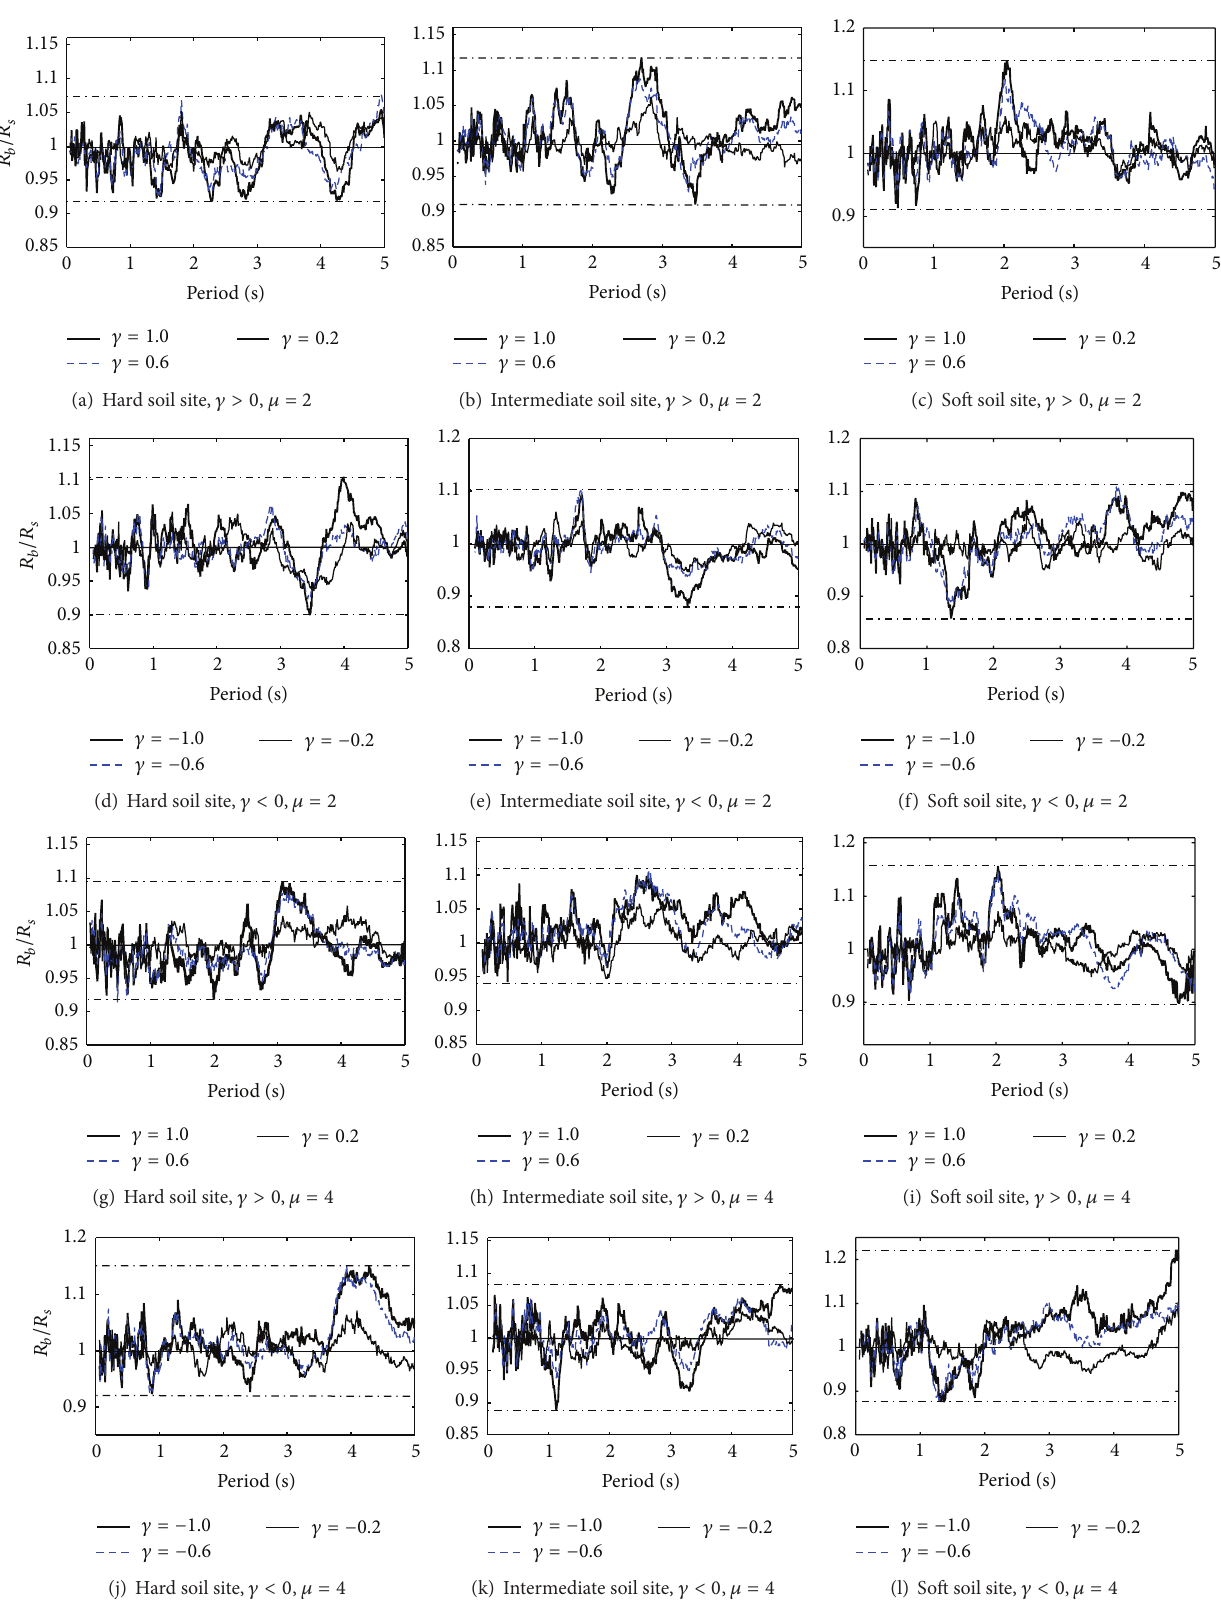
Figure 2: The spectra of 𝑅 𝑏 /𝑅 𝑠 for the three kinds of soil